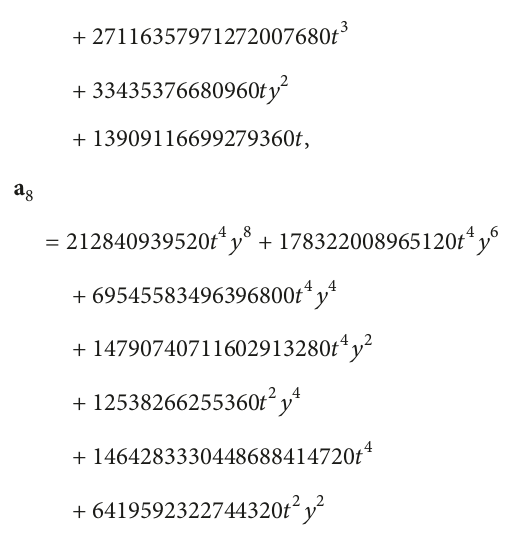
= 0 , 𝑏 = 10 3 , 𝑎 = 0 , and 𝑏 = 0 . 1 1 2 2